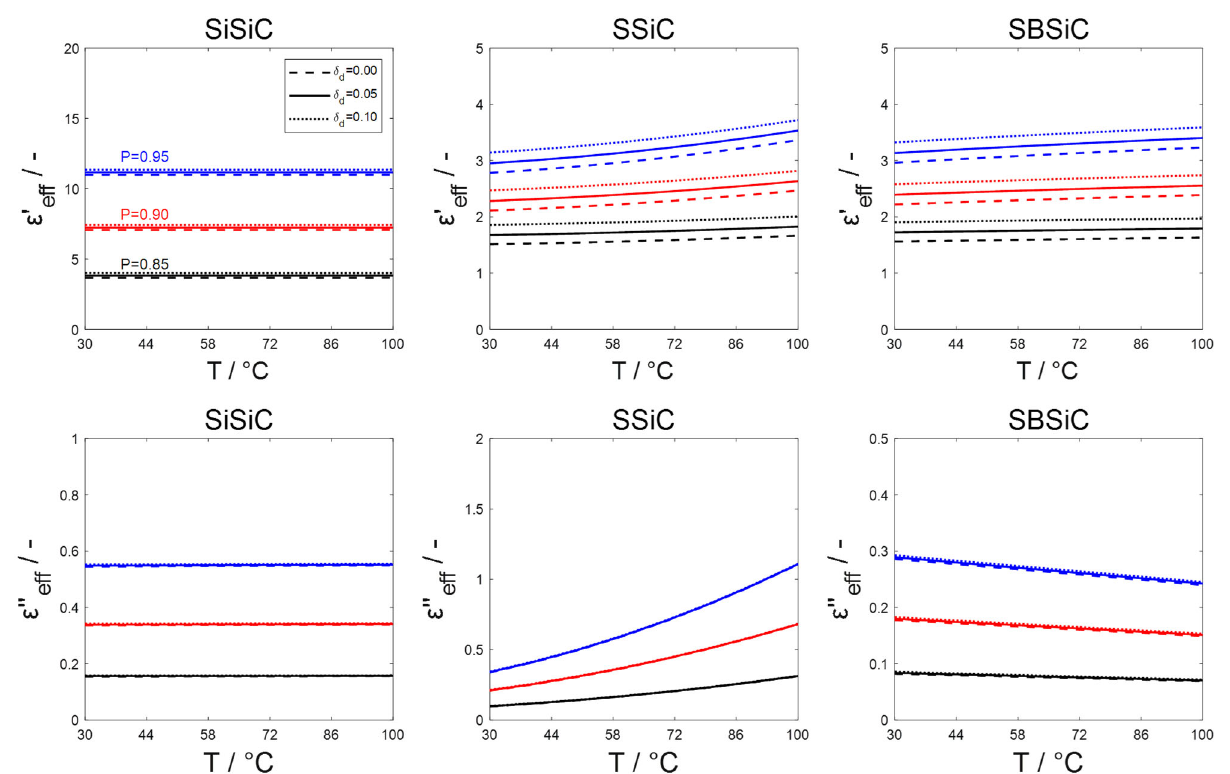
Figure 2. Effective permittivity of the system consisting of foam skeleton, air/steam and dispersed water droplets estimated based on the average skeleton permittivity (notation shown in the upper left subfigure holds for all subfigures).